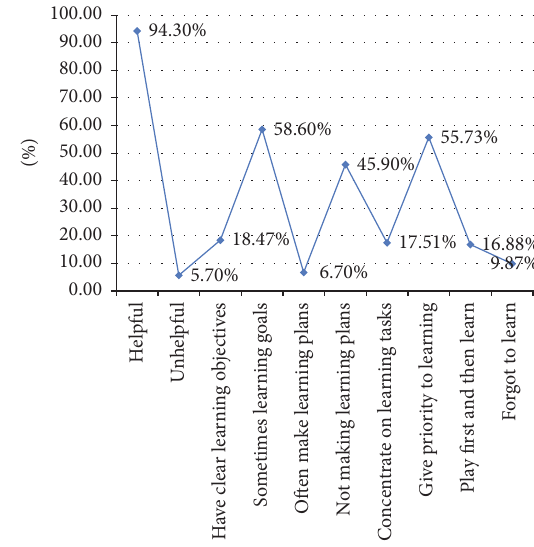
Figure 3: Learning attitude